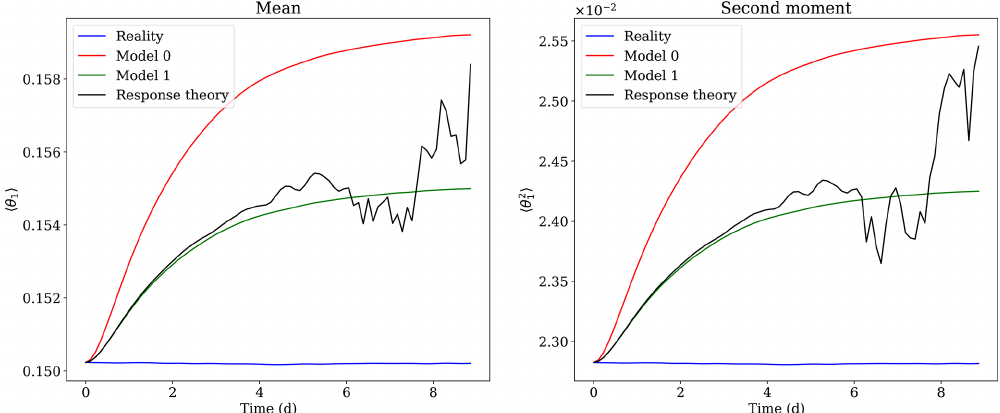
Figure 5. Corrections of the moments of θ 1 from model 0 to model 1 using the response-theory formula of Eq. (49), for the experiment with a modification of the friction coefficient.